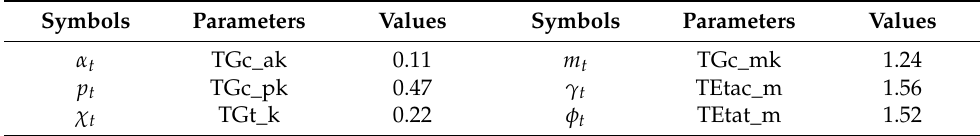
Table 5. The optimal tuning factors.